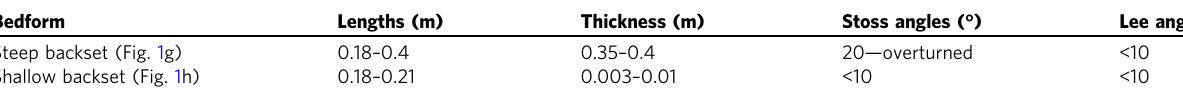
Table 1 Dimensions and angles of our experimental backset bedforms. Bedform